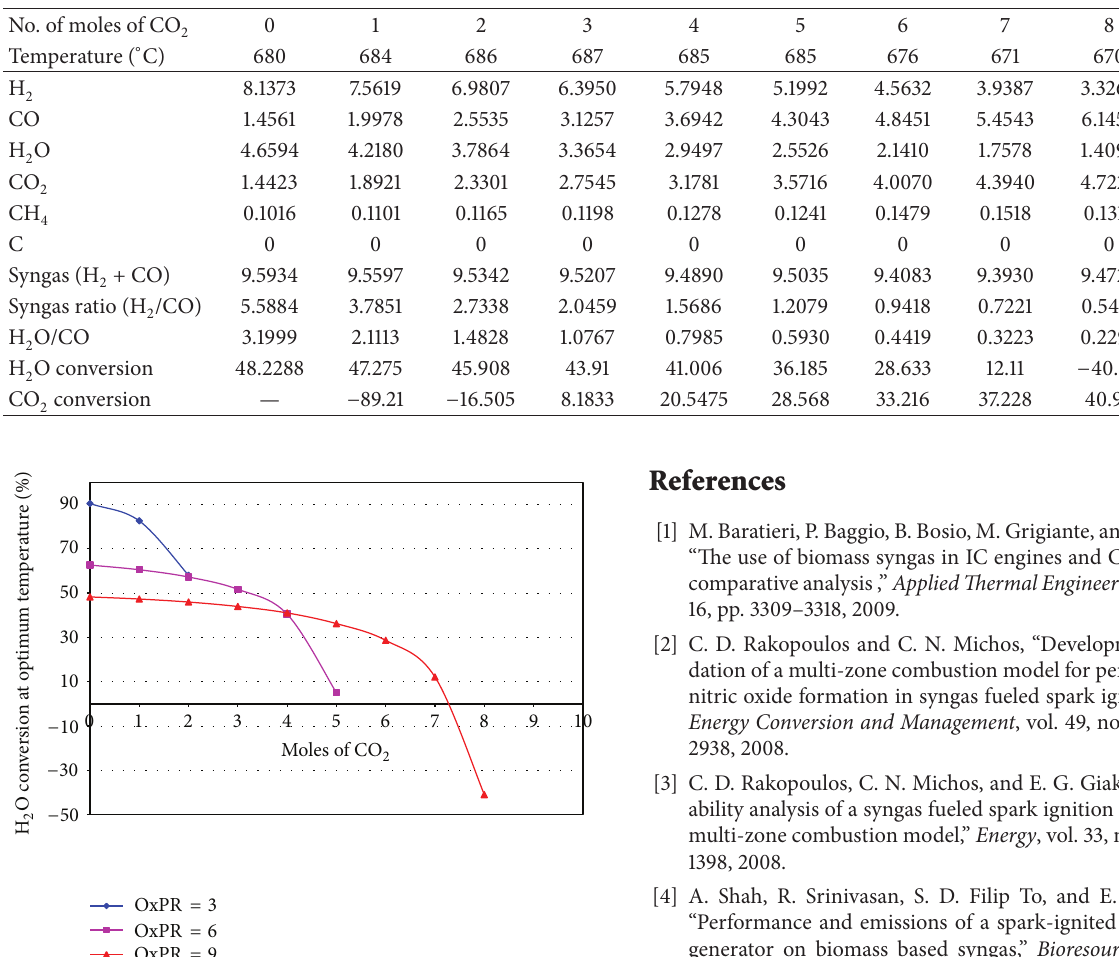
Table 5: Optimum parameters in combined reforming of propane at case OxPR = 9.